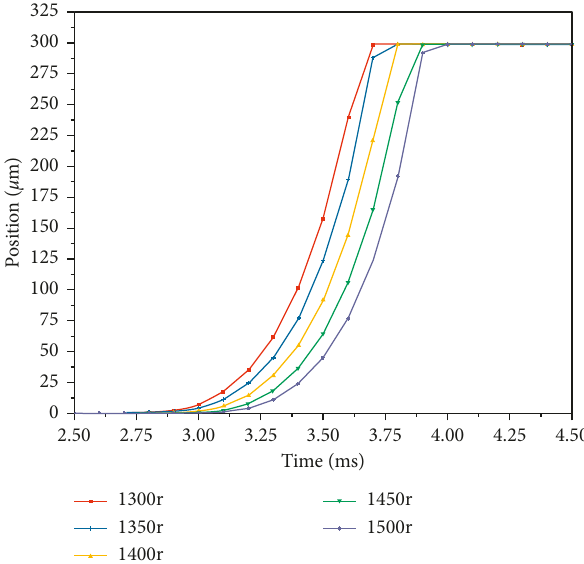
Figure 13: Position under different coil turns.